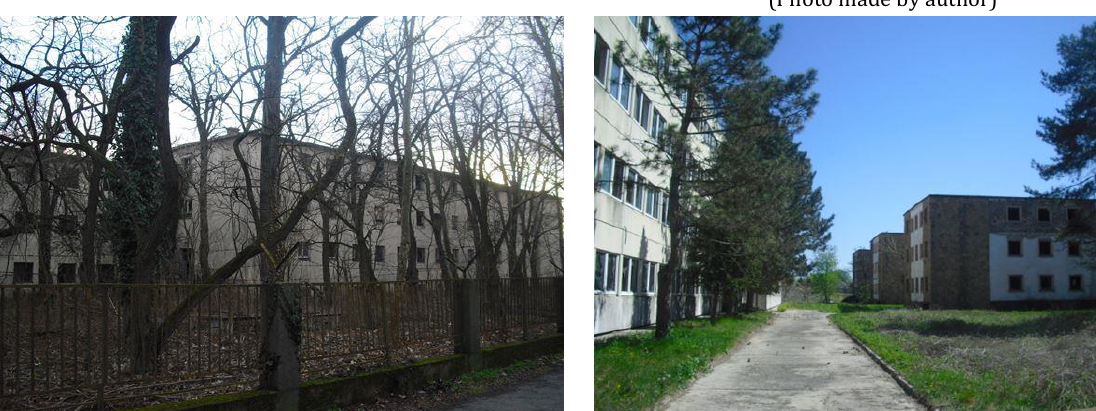
Fig. 16. Cegléd, György Dózsa Barracks